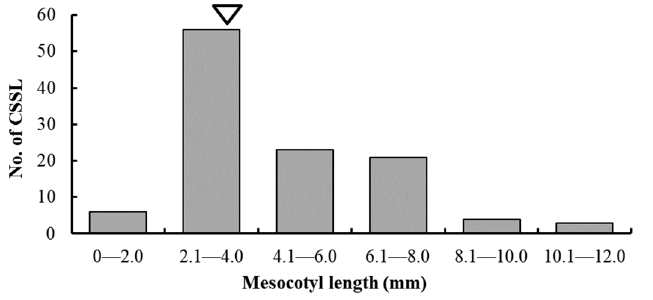
Figure 1. Frequency distribution of the mesocotyl length of the CSSLs. The triangle represents the mean mesocotyl length of Nip.